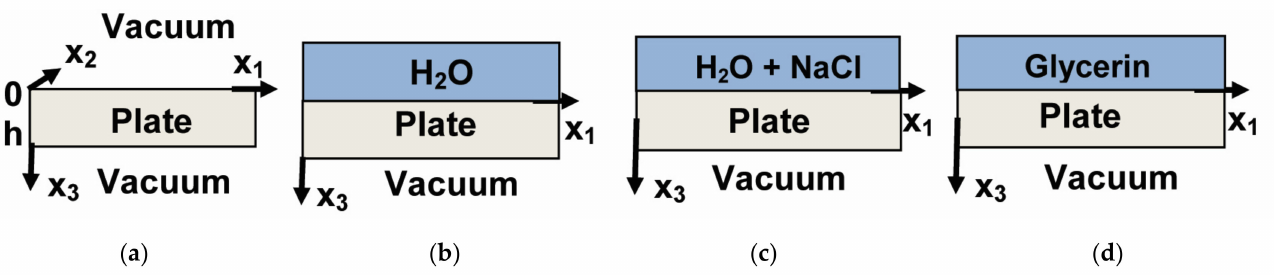
Figure 1. Geometry of the problems: structure “vacuum-plate-vacuum” ( a ), structure “vacuum-plate- H 2 O” ( b ), structure “vacuum-plate- water solution with NaCl” ( c ), and structure “vacuum-plate- glycerin” ( d